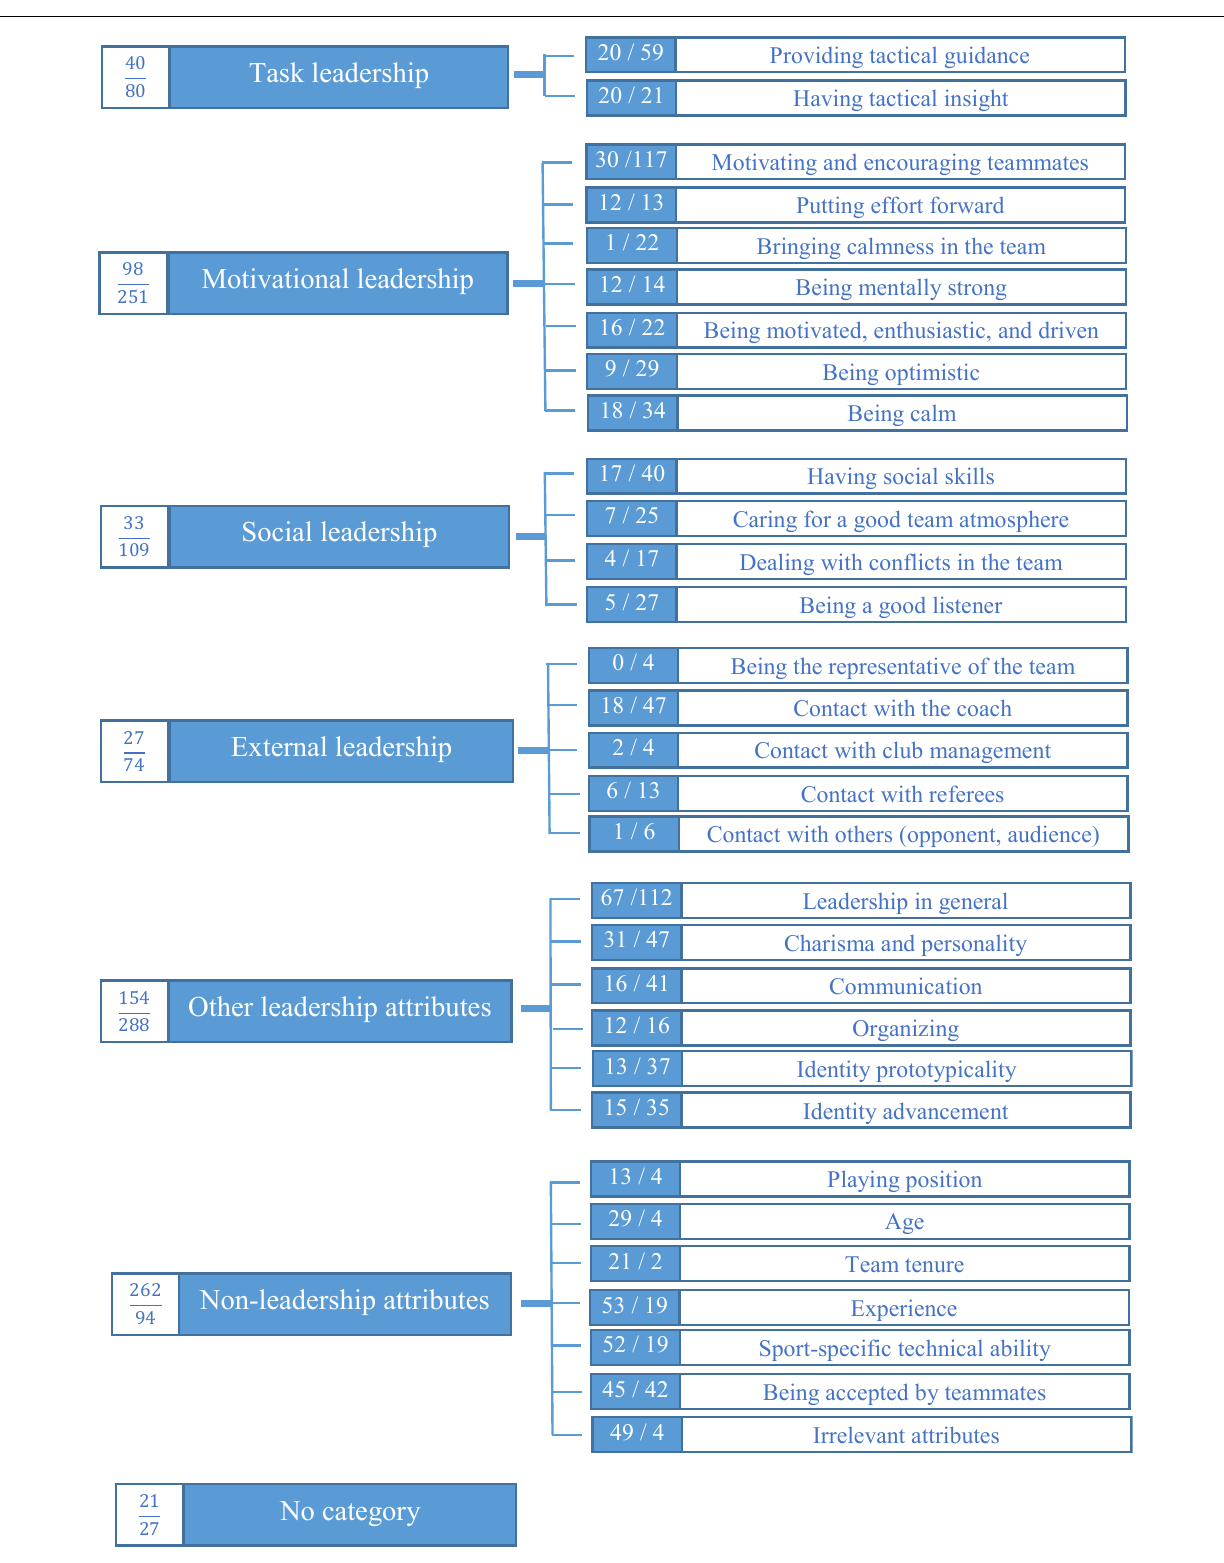
Frontiers in Psychology |